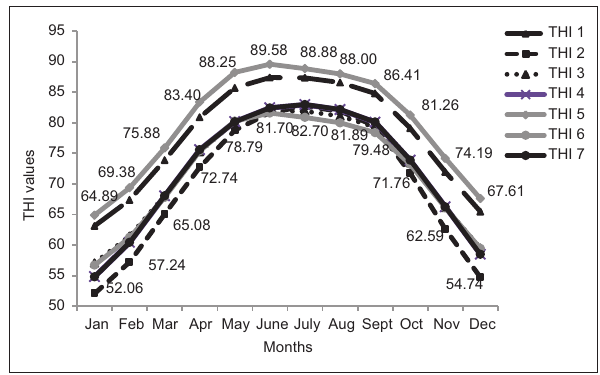
Figure-1: Monthly average temperature humidity index (THI) values with seven different THI models. Data are from Dash et al .